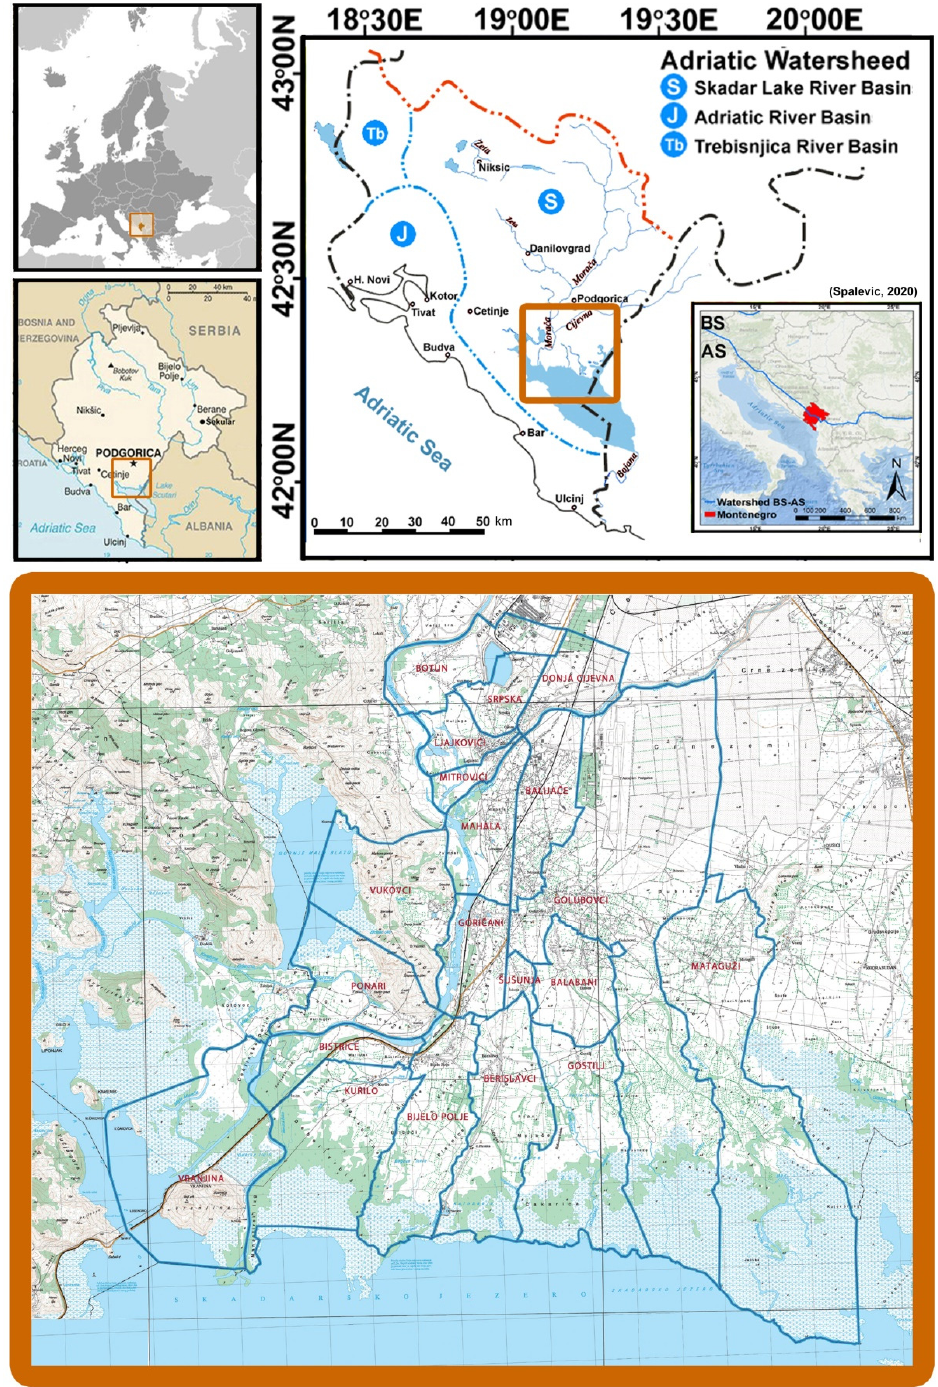
Figure 1. Study area of the Zeta region (15,305 ha). Nowadays it is a region that covers the territory from the south of Podgorica to the Skadar Lake (prepared by Velibor Spalevic).